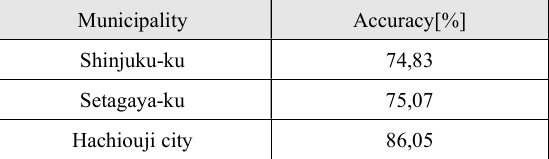
Table 5 . Accuracy for each municipality